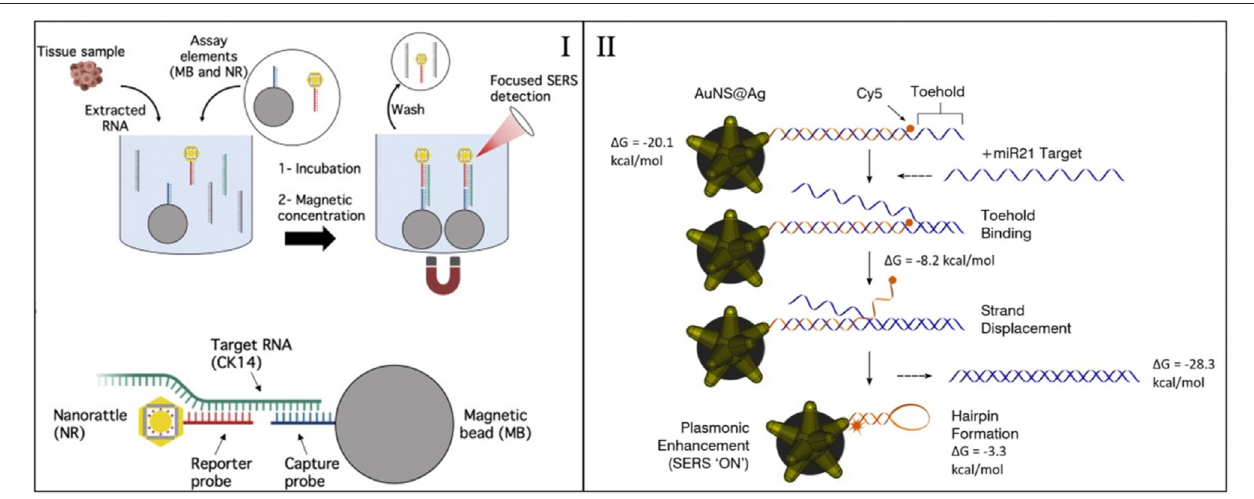
FIGURE2 |(I) Sensing mechanism themagnetic capture of nanorattles forthe detection ofCK14 RNA. Adapted fromDukeset al.(2020). (II) Sensing mechanism of an inverse molecular sentinel. Adapted from Crawford et al. (2020).